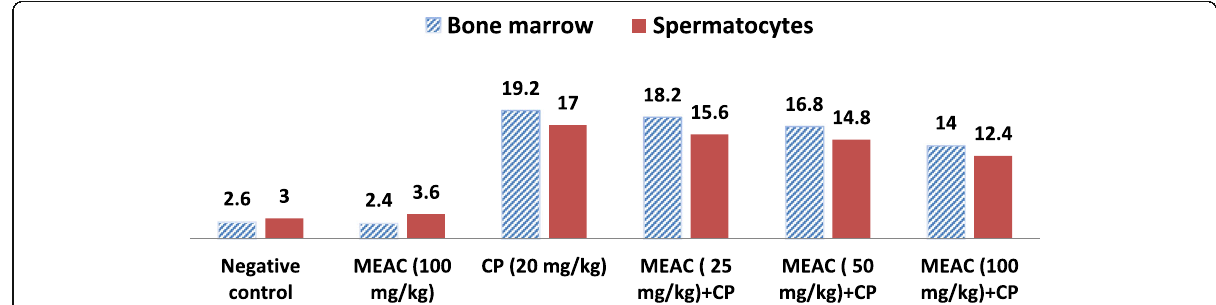
Fig. 1 Frequency of chromosomal abnormalities induced in mouse bone marrow and spermatocytes after treatment with different doses of Albizia chinensis extract (MEAC) and cyclophosphamide (CP) showed a dose-related